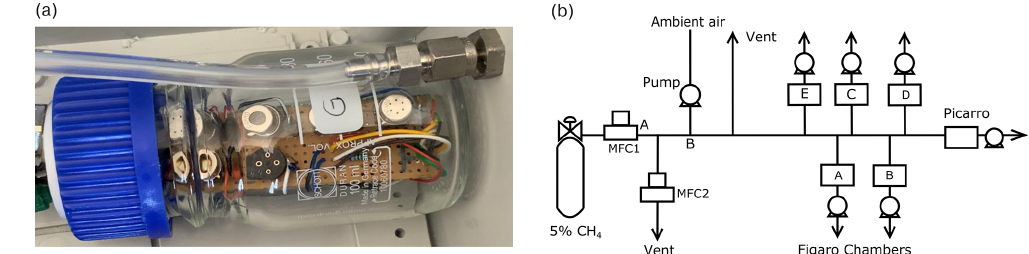
Figure 1. (a) Example of a chamber with three sensors inside. (b) Scheme of the spike creation experiment. Table 1. Summary of the sensors included on each logger box. Chamber Figaro ® TGS Temperature and relative Temperature and Load resistor humidity sensor pressure sensor TGS 2600 DHT22 BMP280 50k (cid:127) A TGS 2611-C00 TGS 2611-E00 TGS 2600 SHT75 BMP280 50k (cid:127) B TGS 2611-C00 TGS 2611-E00 TGS 2600 SHT75 BMP280 50k (cid:127)